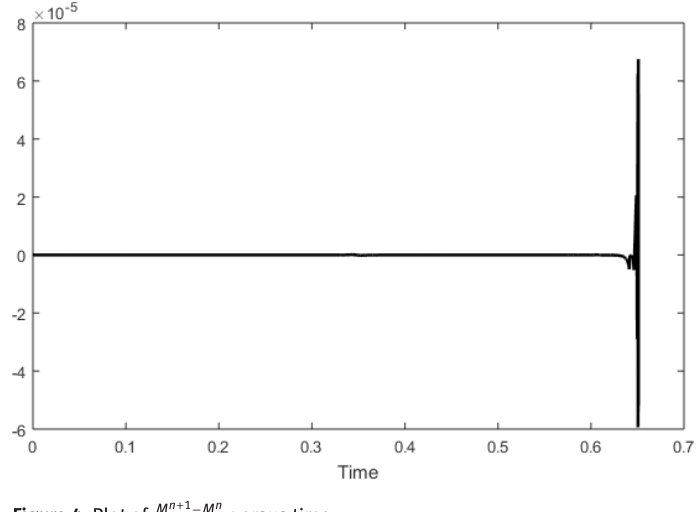
versus time. M n